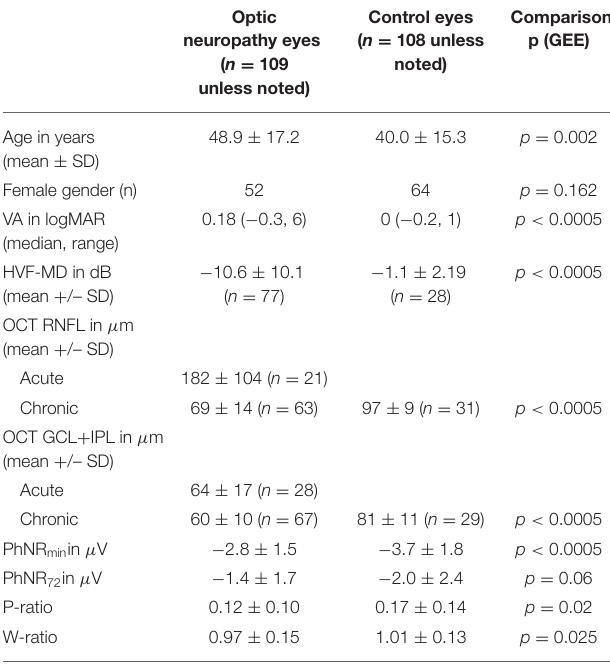
TABLE 1 | Unadjusted comparison between eyes with and without optic neuropathy.